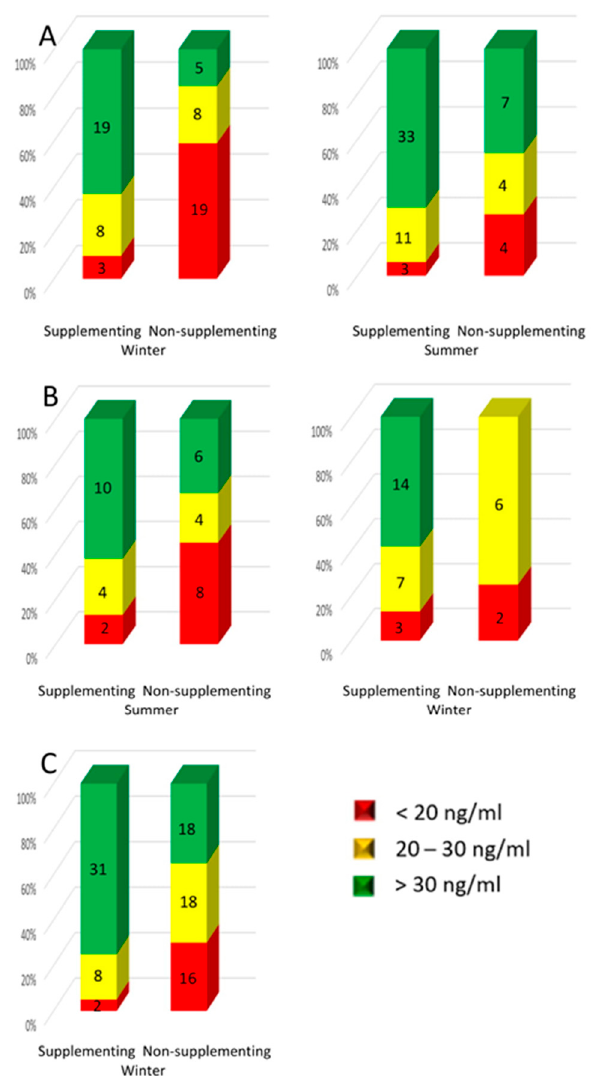
Figure 3. Percentage of patients in the healthy control group and the groups of women treated for breast cancer, with deficiency, suboptimal and optimal vitamin D levels depending on supplementa- tion of vitamin D and season—winter/summer. Group A—women treated for breast cancer tested the first time in winter ( A ); Group B—women treated for breast cancer tested the first time in summer ( B ), and the control group tested during winter only ( C ). The number of persons in every subgroup is listed on the bars.